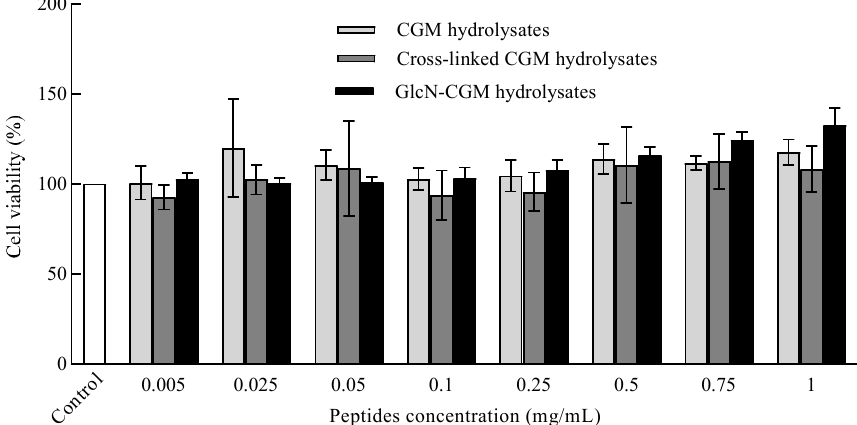
Figure 4. Cell viability assay of CGM hydrolysates, cross-linked CGM hydrolysates and GlcN–CGM hydrolysates at different concentrations in LO2 cells assayed via methyl thiazole tetrazolium (MTT). The values represent the mean ± SD of three independent experiments.